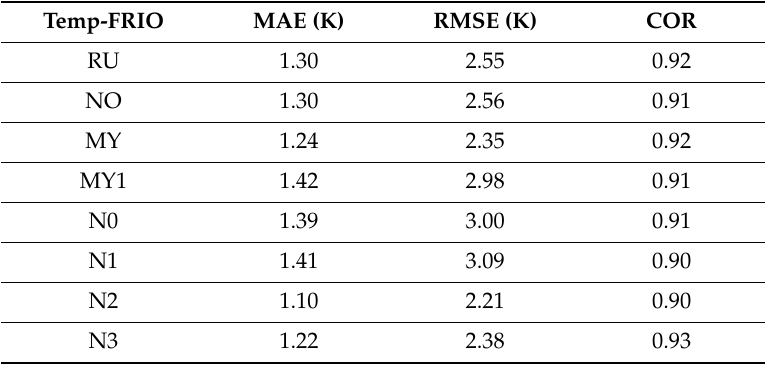
Table A10. Mean absolute error (MAE), root mean square error (RMSE), and correlation coe ffi cient (COR) for surface temperature (Temp) at Frioul (France) station denoted as FRIO.